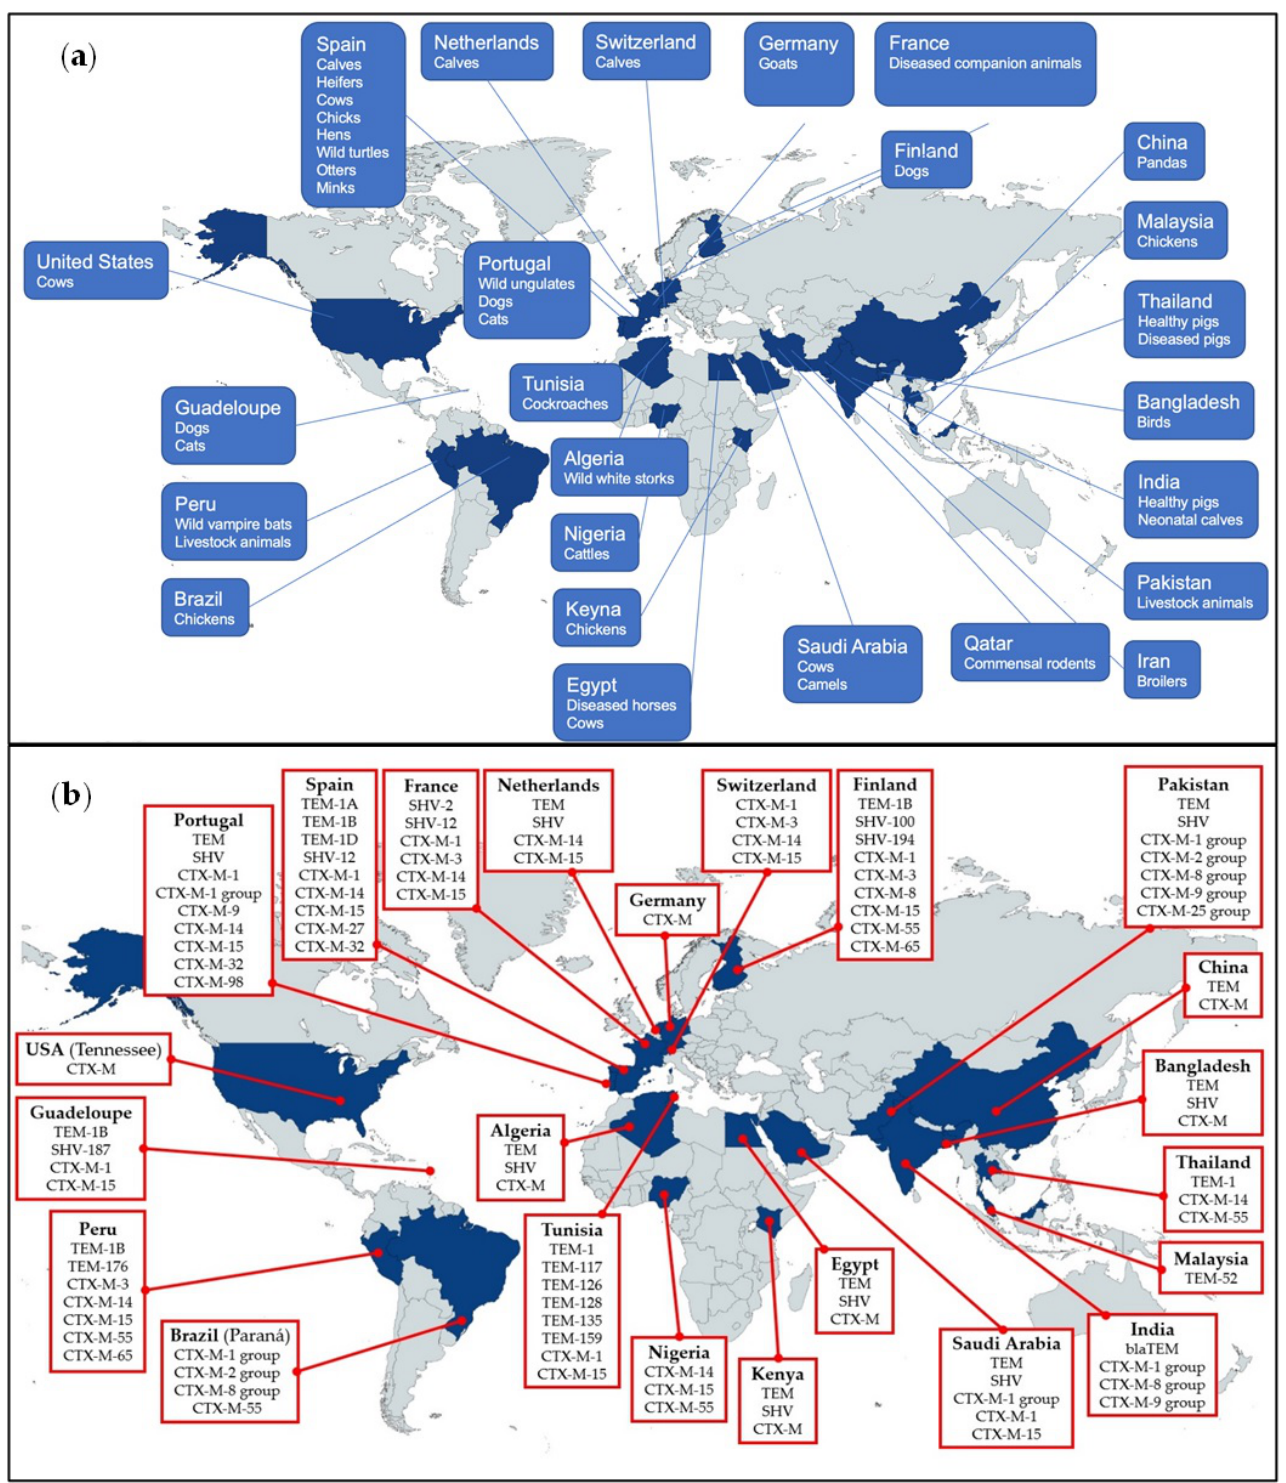
Figure 1. ( a ) Countries that reported the presence of ESBL-producing bacteria in animals. ( b ) Coun- tries that reported the presence of ESBL-subtype distribution in animals.